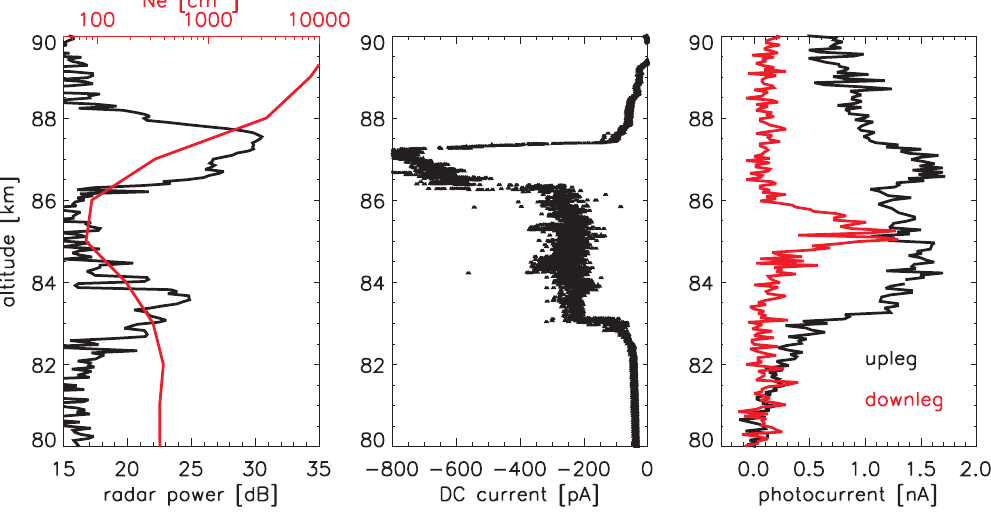
Fig. 4. Overview of measurements with the ECOMA-particle detector in comparison to ALWIN VHF-radar measurements of PMSE and absolute electron densities from the Faraday propagation experiment (left panel). Mid panel: DC-current measured by the ECOMA-particle detector owing to charged particles reaching the detector electrode inside the Faraday cup. Right panel: Photoelectron currents recorded by the ECOMA-particle detector on upleg (black line) and downleg (red line) of the rocket flight.